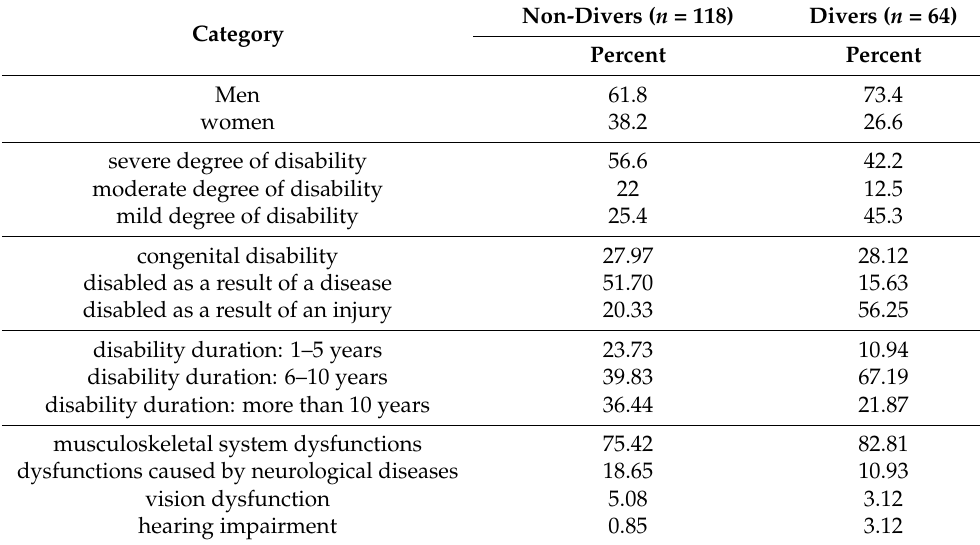
Table 1. Description of the analyzed group [16].